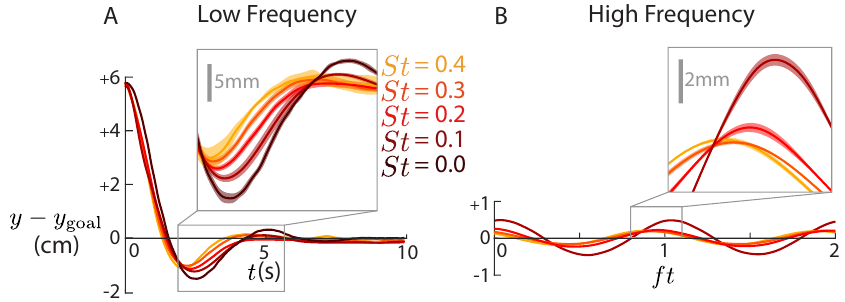
Figure 3. The response in lateral position ( y ) depends on Strouhal number. ( A ) The lowpass-filtered lateral position settles into a new equilibrium after around 5s. The overshoots and settling times (see Figure 1D) are larger for lower Strouhal numbers. Inset: average, dark lines; average ± σ ( n = 5), shaded bands. ( B ) The high-pass filtered lateral position oscillates at the pitching frequency. The phases and amplitudes of oscillation (see Figure 1E) decrease with higher Strouhal